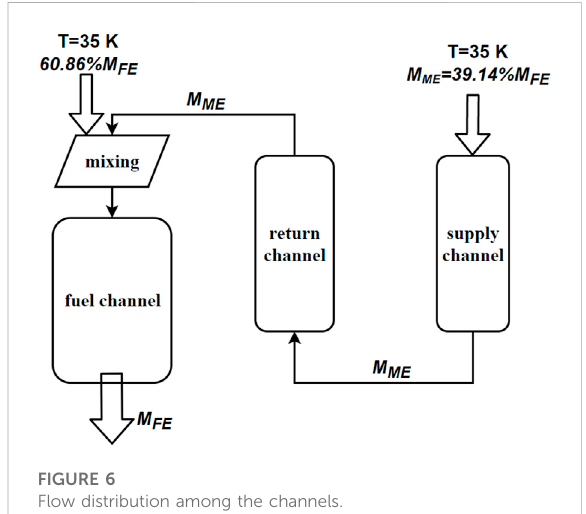
FIGURE 6 Flow distribution among the channels.